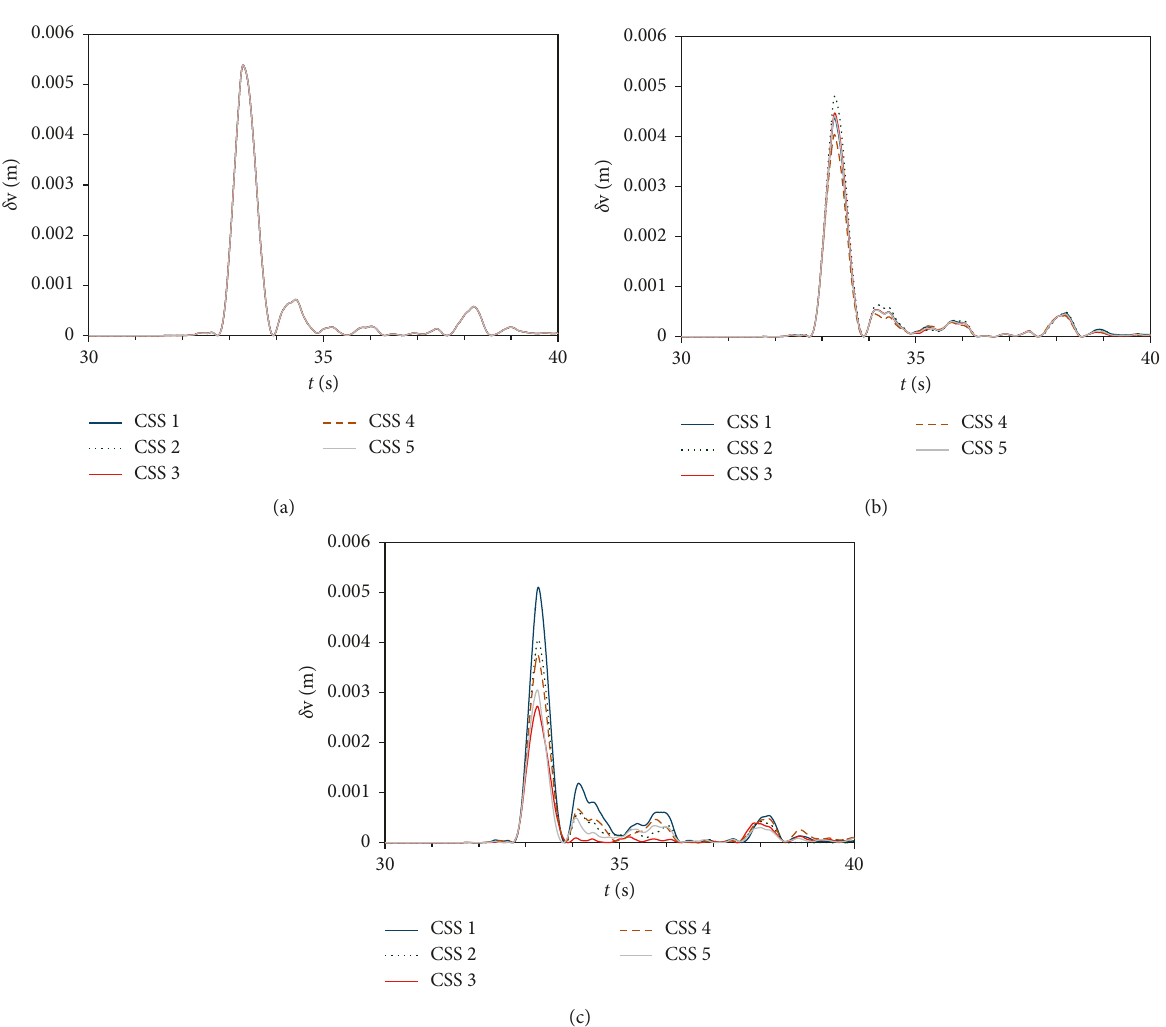
a , and (c) C23 with μ b .